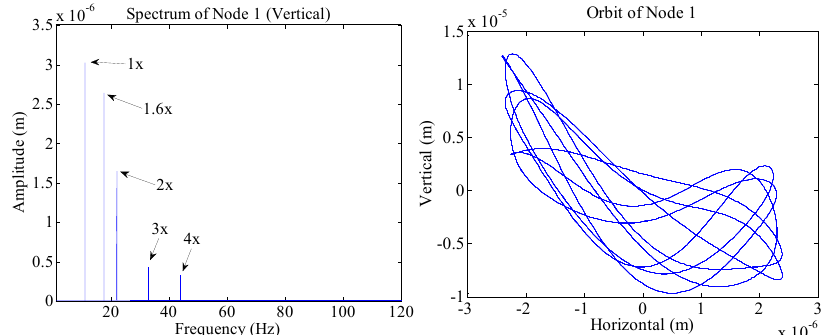
Figure 10. The spectrum and the orbit of Bearing 1 (misalignment at Bearing 3).